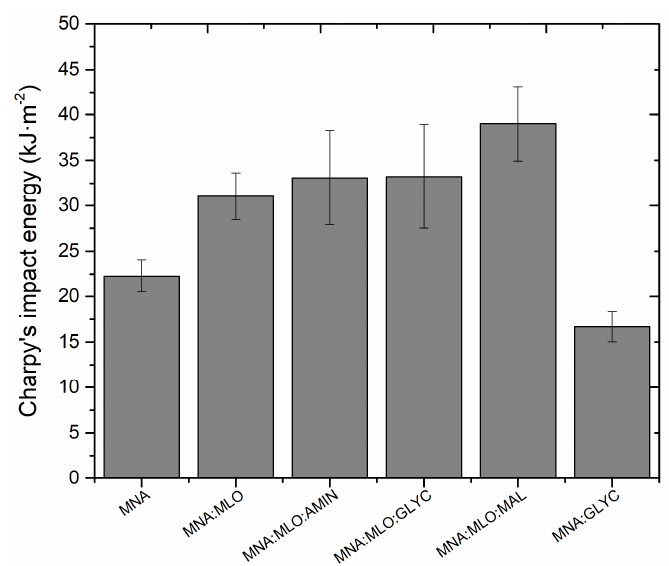
Figure 5. Variation of the impact energy (Charpy test) of composites based on ELO epoxy resin cross-linked with MNA/MLO mixture and flax fabric reinforcement with different surface treatments.